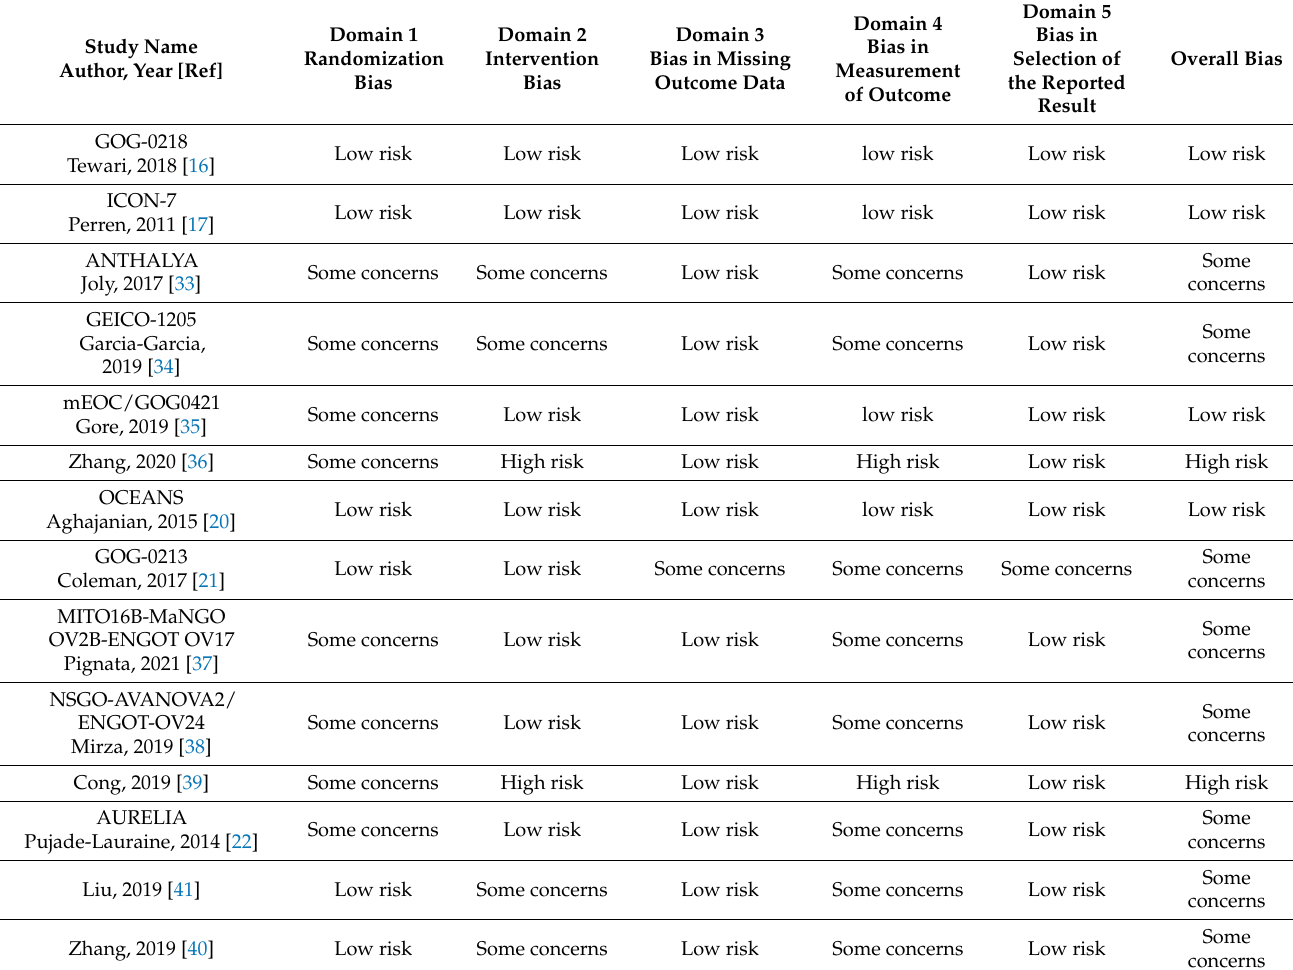
Table 2. Risk of Bias analysis of the included studies, according to the Cochrane Risk of Bias (RoB)-2 tool [32] .